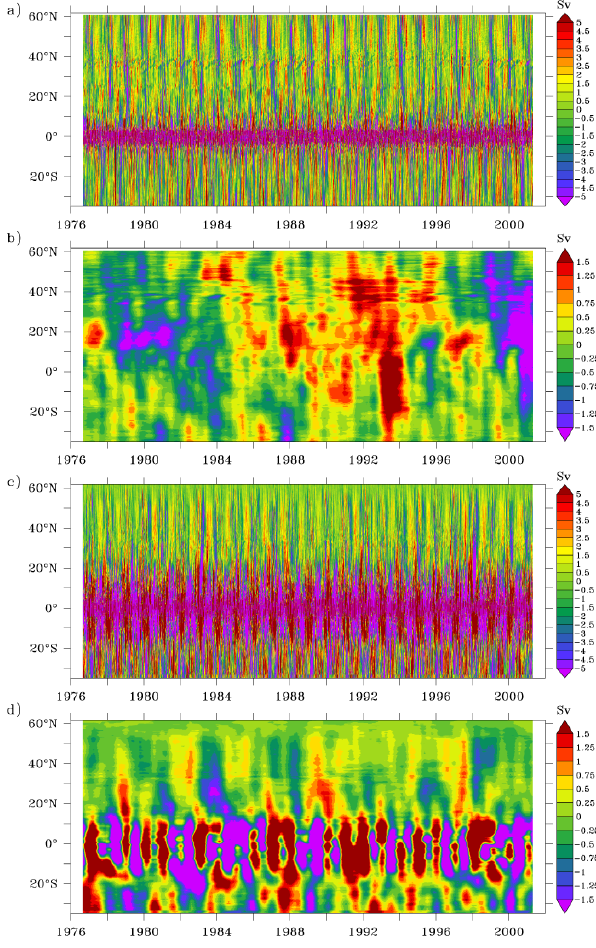
Fig. 17. Hovm¨oller diagram of the MOC difference between exper- iments A025 and B025 at 1000m depth. (a) , (b) Chaotic Atlantic MOC variability on subannual (a) and interannual (b) timescales. (c) , (d) As panels (a) , (b) but for Indo-Pacific.